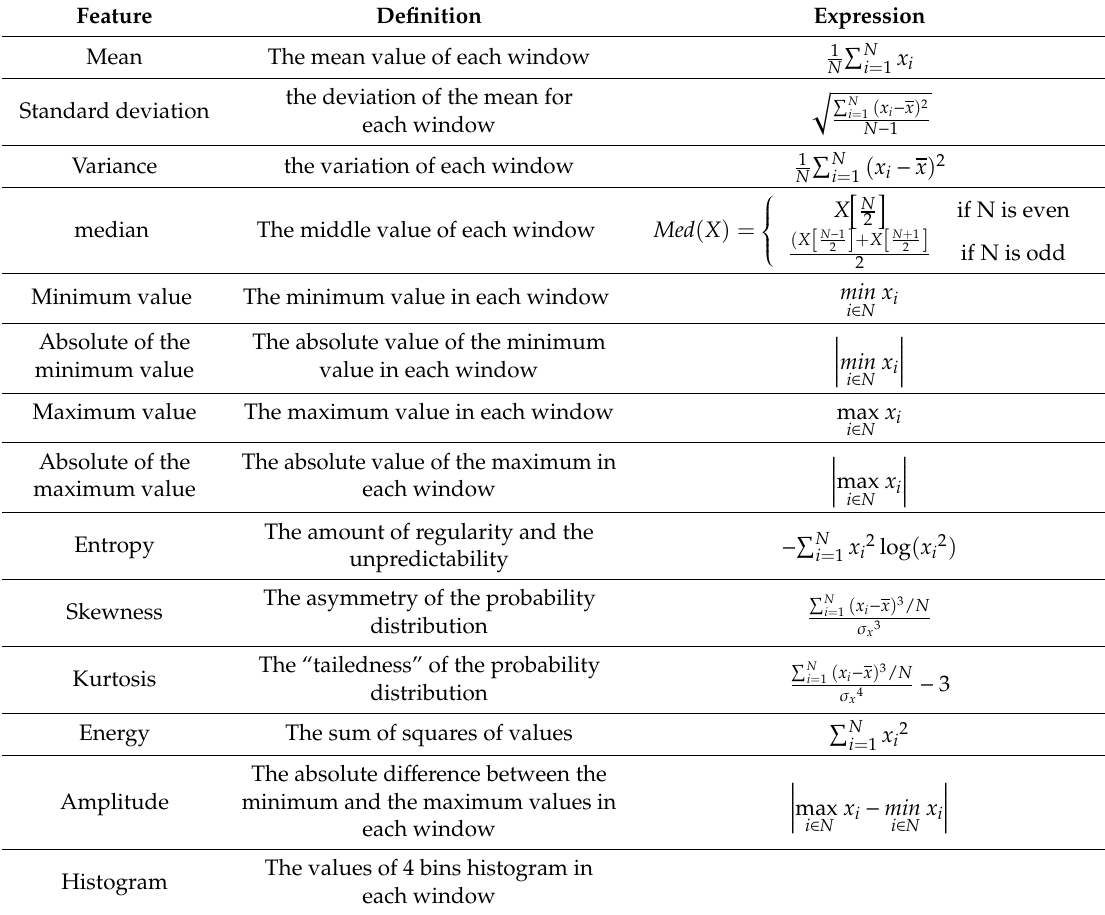
Table 1. Statistical Features.